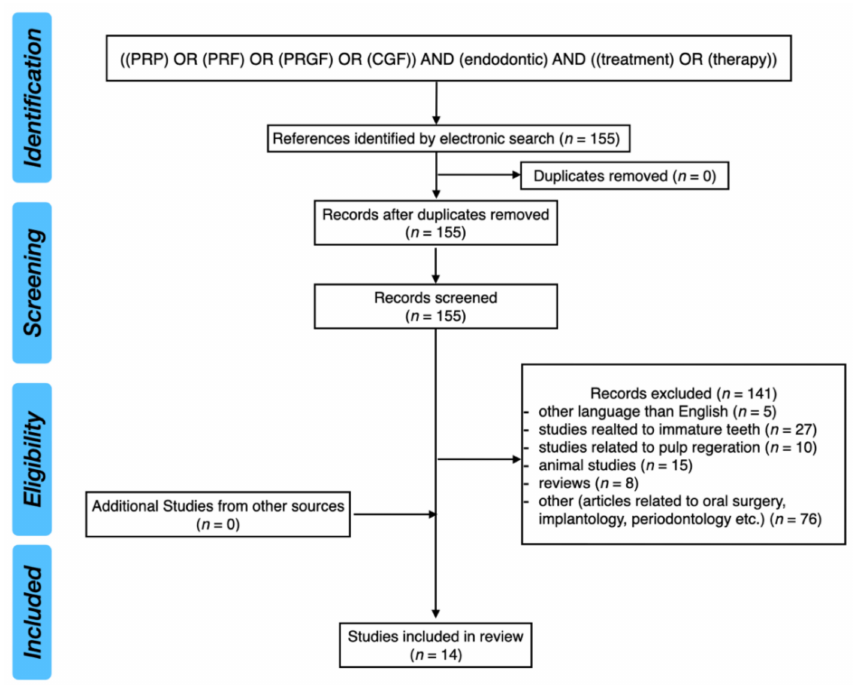
Figure 1. PRISMA flow diagram for review of the